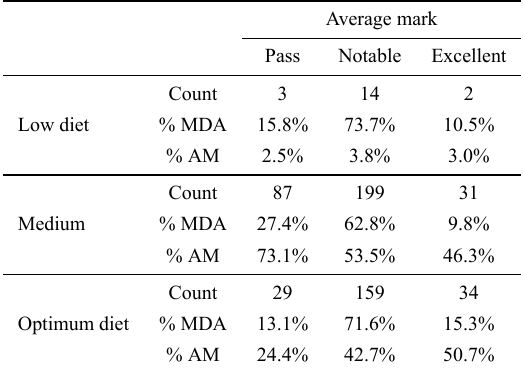
Table 3. Relationship between adherence to the Mediterranean diet and average mark ( p =